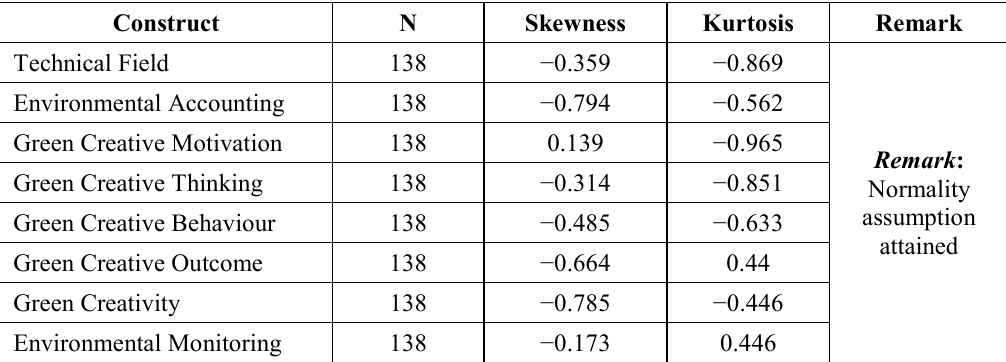
Table 1. Normality